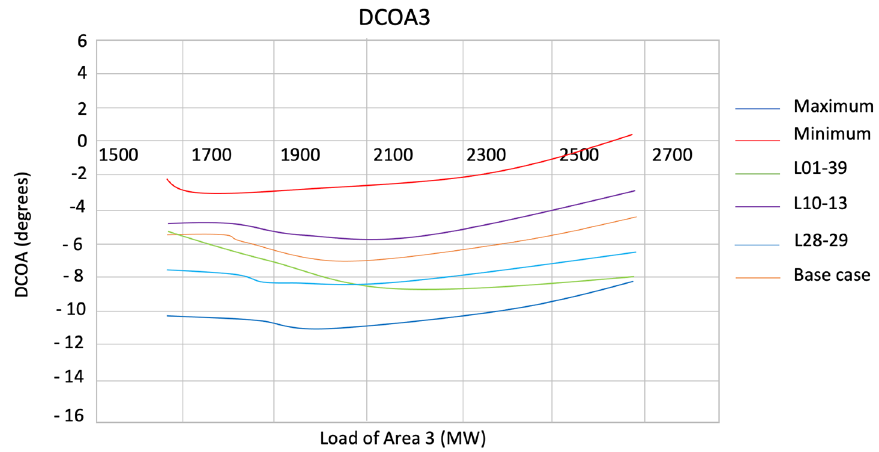
Figure 12. Angular characterization for contingencies N-1 in operational area 3.